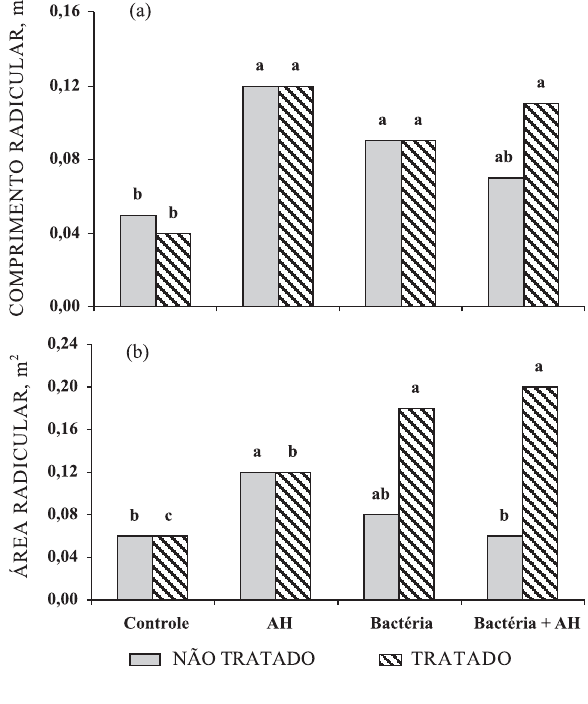
Figura 2. Comprimento radicular total (a) e área su- perficial radicular (b) estimados pelo software Delta T-scan ( demo version ) de microtoletes de cana-de-açúcar cv RB 72-454 tratados termica- mente com água a 50,5 °C por duas horas (trata- do) ou não (não tratado) e submetidos à imersão por 12 h numa solução que continha: água (con- trole), ácidos húmicos (AH) na concentração de , Herbaspirilum seropedicae es- 20 mg L -1 de C AH tirpe HRC 54 na concentração de 10 8 células mL -1 de água (Bac) e pelo uso em conjunto de AH e bac (Bactéria + AH) Médias seguidas por letras diferentes são estatisticamente diferentes pelo teste Tukey (p < 0,05). Comprimento: N = 4; CV = 23%; F = 8. Área: N=5; CV = 21 %; F